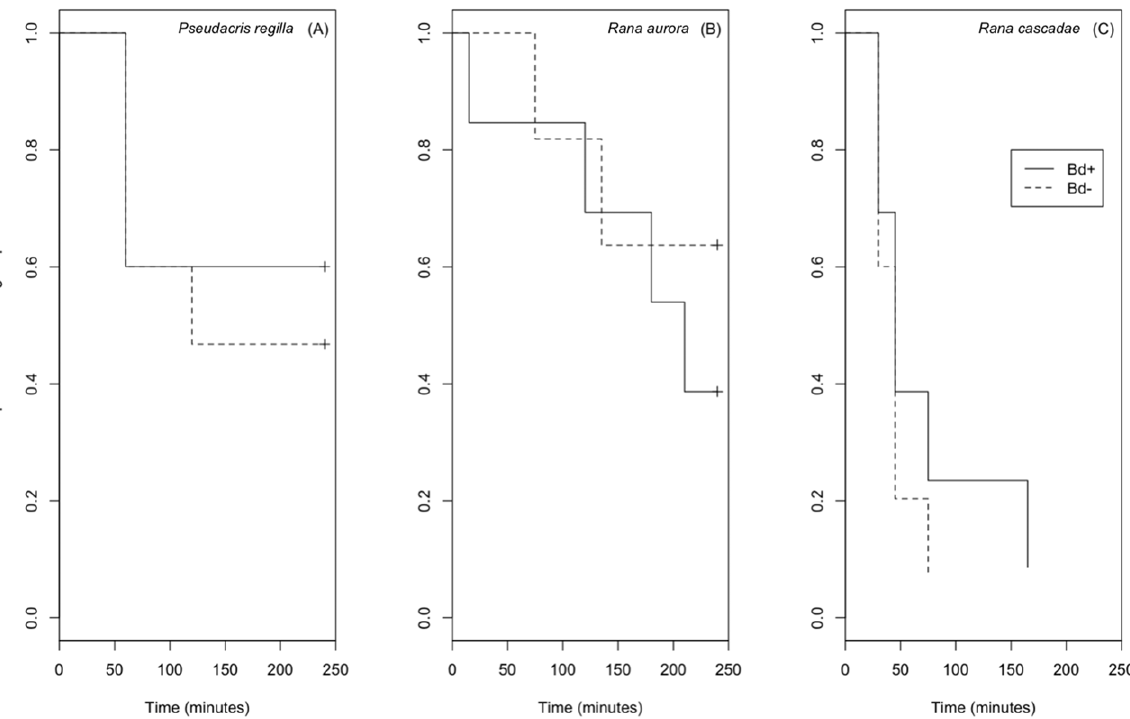
Figure 2. Survival of tadpole prey of three amphibian species ( P.regilla , R.aurora , and R.cascadae ) from two Bd treatments (Bd + , Bd 2 ) during feeding trials with two predator species ( Taricha granulosa and Ambystoma macrodactylum ) in the following species combinations: Taricha - P.regilla ; Taricha - R.aurora ; Ambystoma - R.cascadae ). The symbol ( + ) at the end of survival curves for P. regilla and R. aurora denotes censored data, where some prey survived beyond the end of the feeding trial. All R. cascadae tadpoles were consumed by